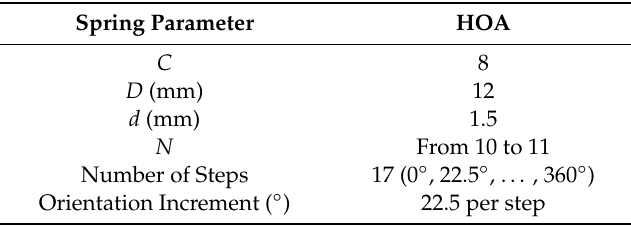
Table 3. Simulation parameters for